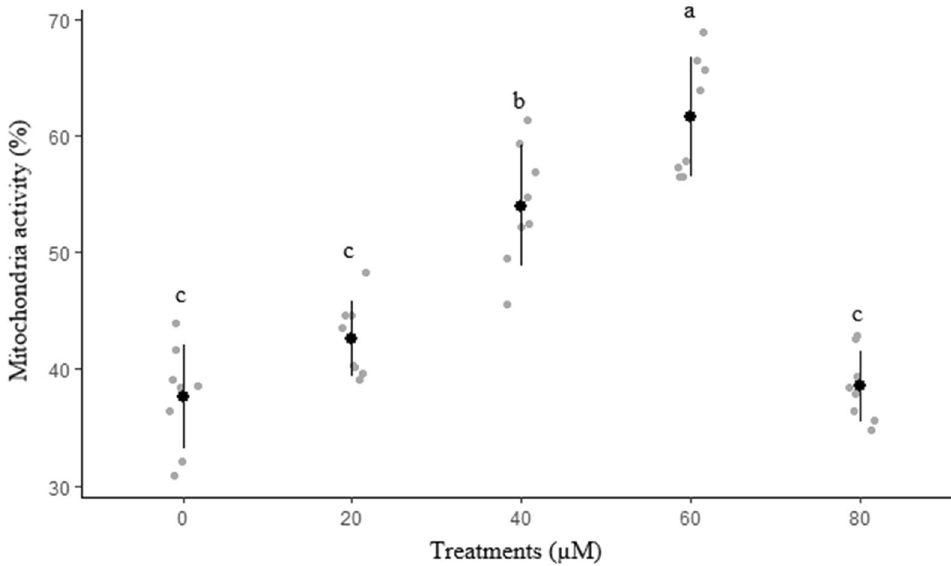
Figure 4. Effect of different levels of rosiglitazone on mitochondria activity of ram sperm.